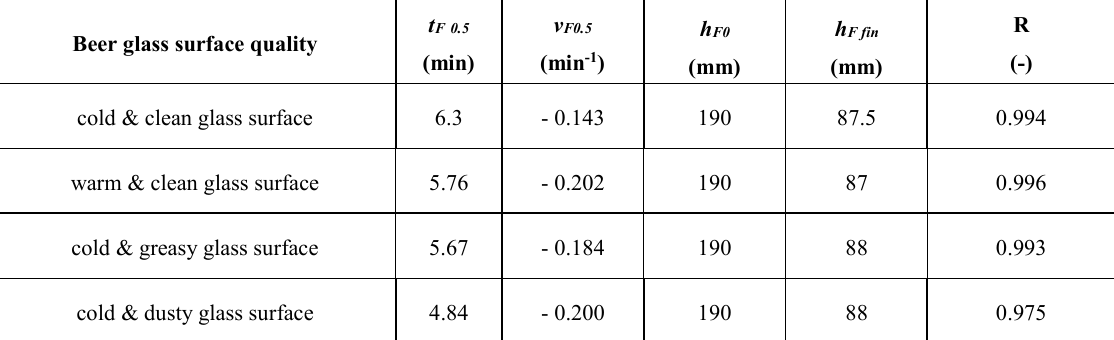
Table 1. Foam decay - effect of beer glass surface quality: S-curve parameters. Beer glass surface